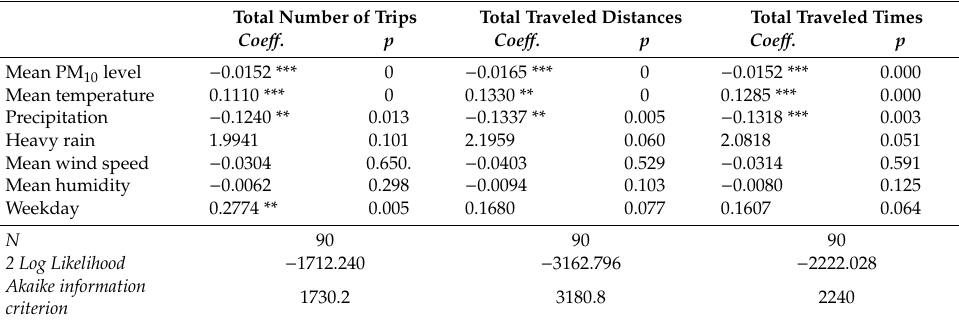
Table 11. Estimation results for bike sharing use using PM 10 level data in winter. Coe ff